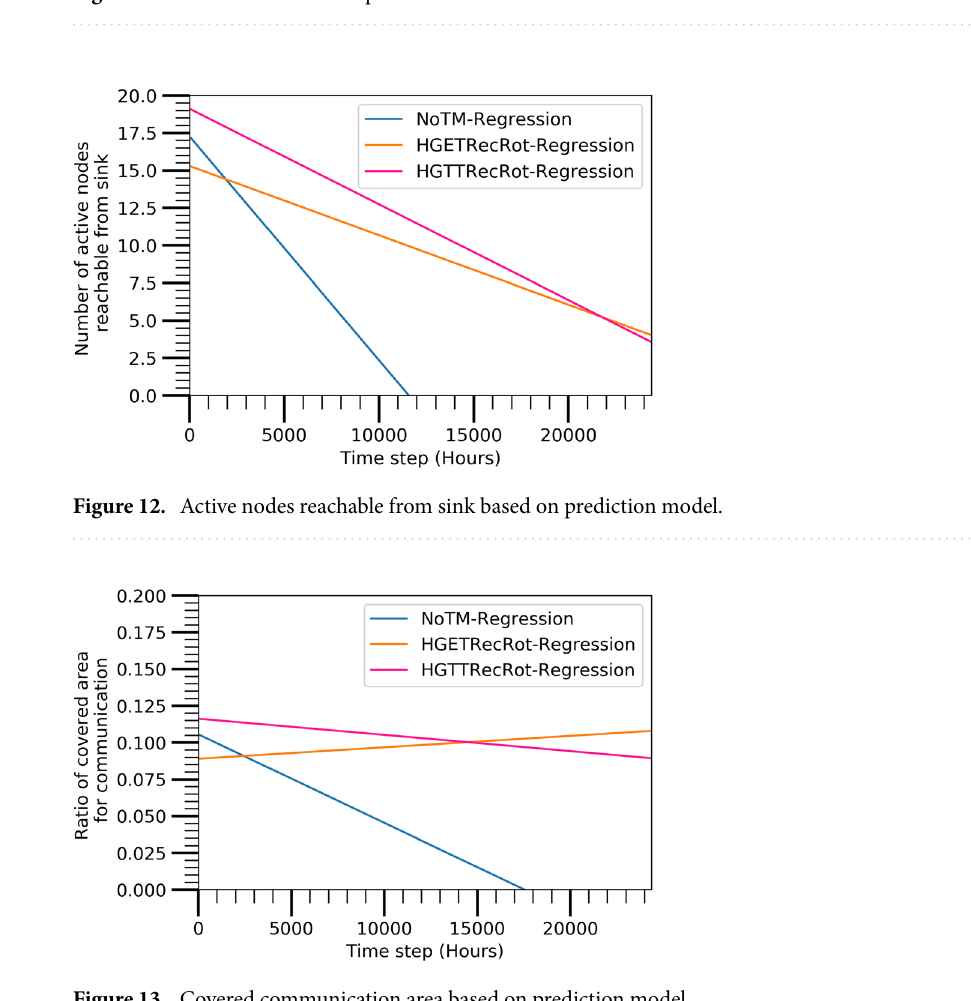
Figure 11. Alive node based on prediction model.